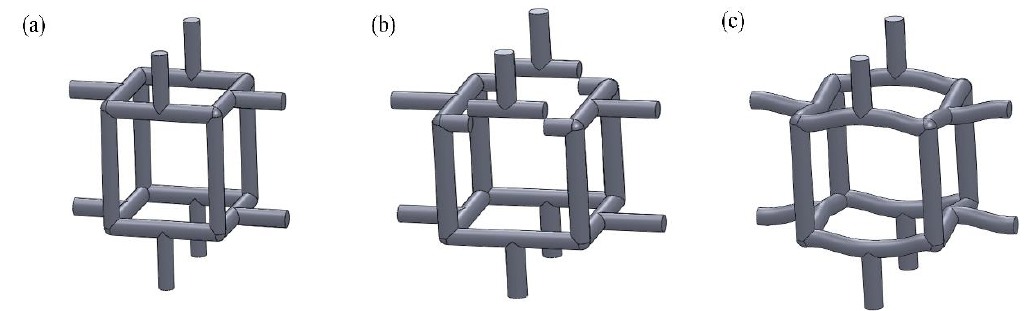
Figure 10. The mechanical model of network structure: ( a ) the unit model; ( b ) the brittle model; ( c ) the elastic plastic model.